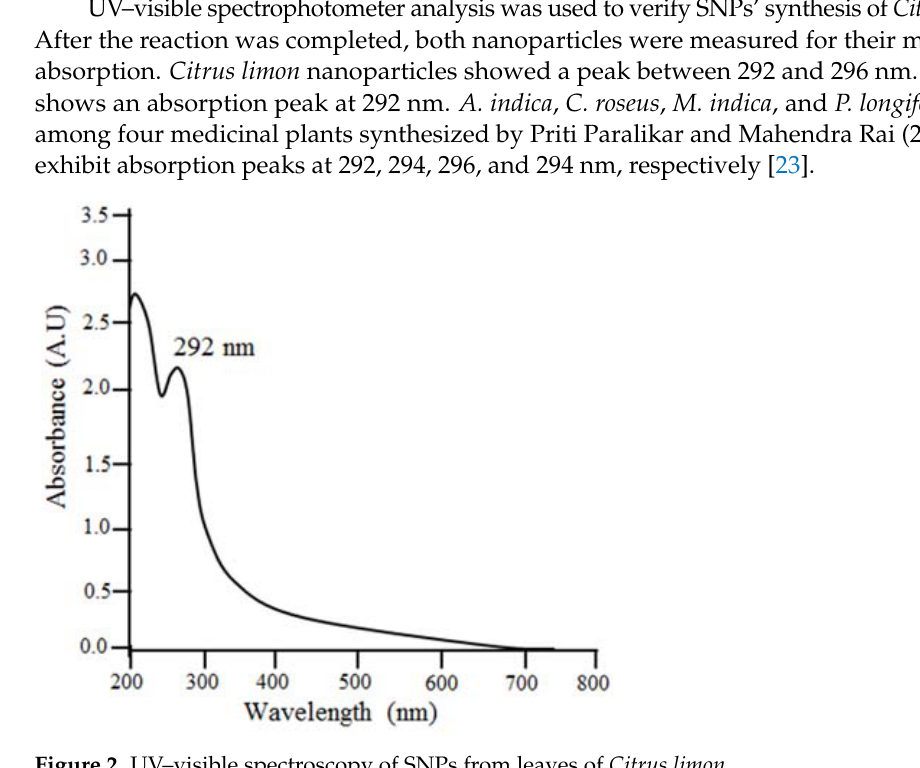
Figure 1. ( a ) Zeta size and ( b ) Zeta potential of SNPs.